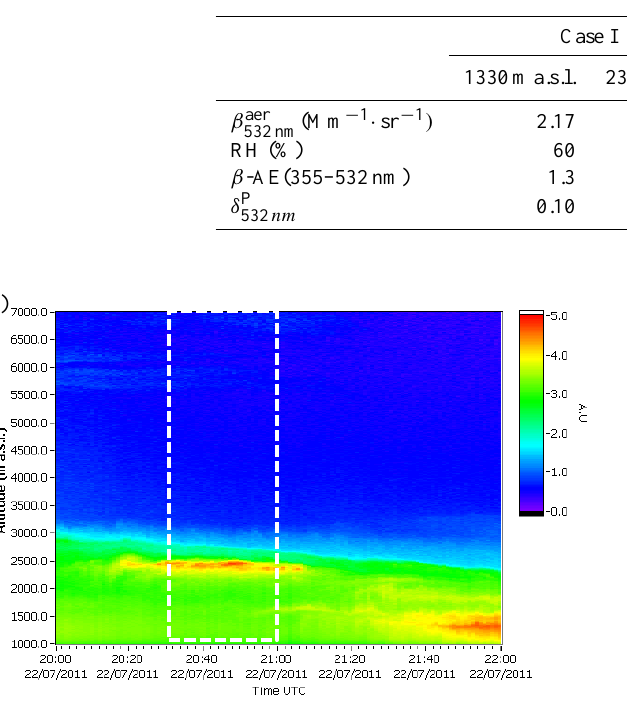
Table 1. Values of the different aerosol properties at the lowest and highest altitudes of the analyzed layers for Case I and Case II.